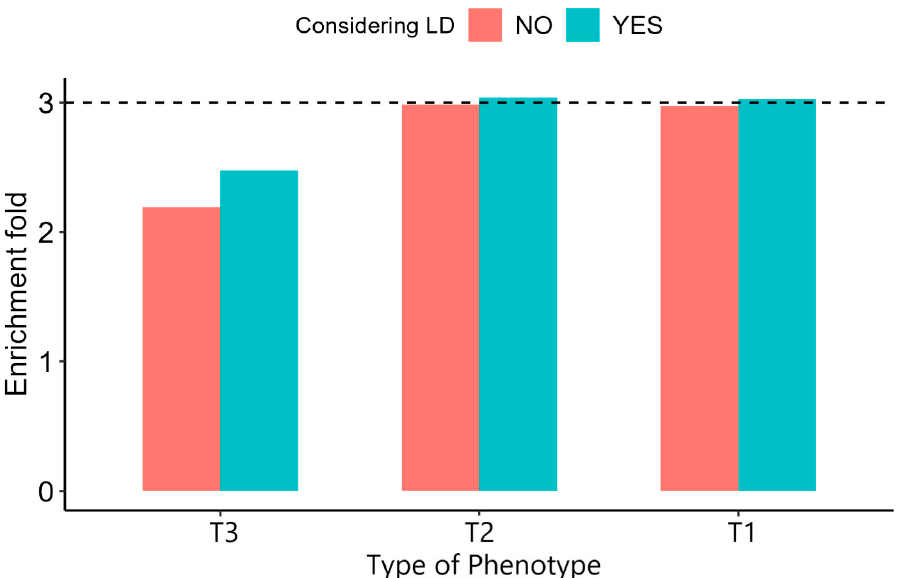
Figure 4. Performance of enrichment model with (LDAK) and without ( α -model) LD weights. Com- paring the difference between the real enrichment and the estimated enrichment of the model with and without LD weights. Colors represent the existence of LD weight for models. The dotted line represents the true enrichment.